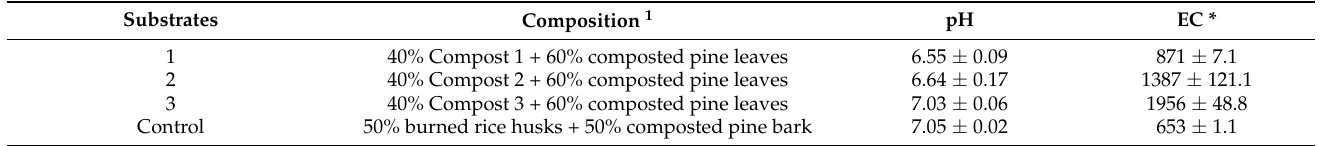
Table 3. Initial substrate formulation, pH, and EC values (mean ± standard deviation with n =